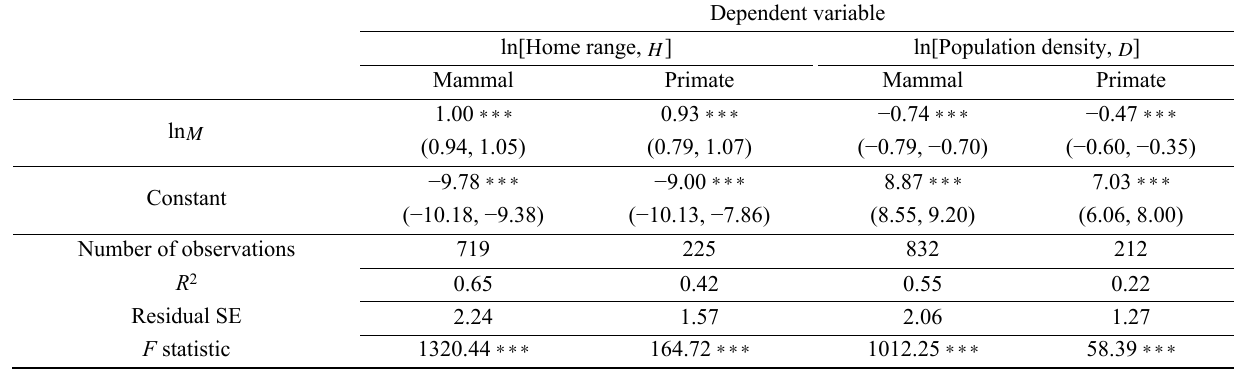
Table 2 Home range and population